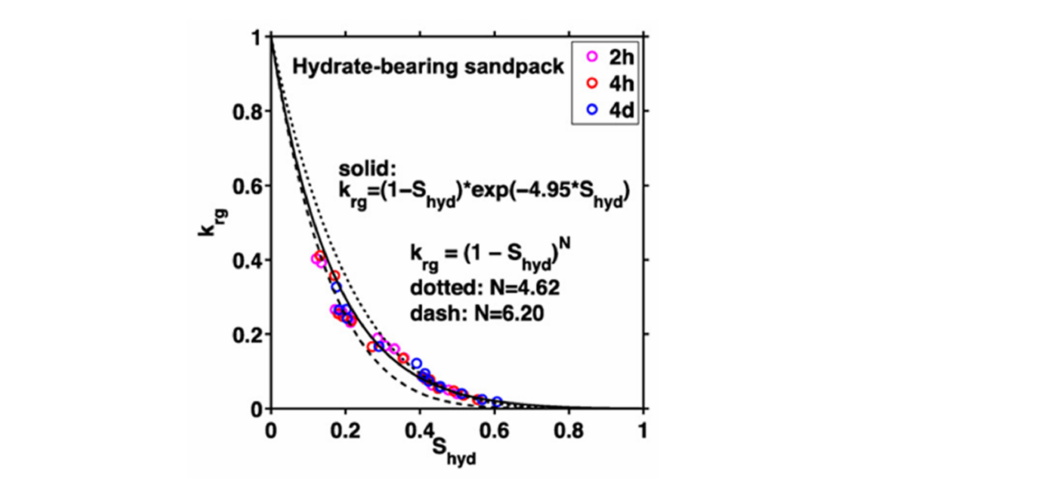
Figure 22. Gas relative permeability versus hydrate saturation, Corey-type fits, and new model fits. Reprinted with permission from Ref. [65]. Copyright 2022 American Geophysical Union.